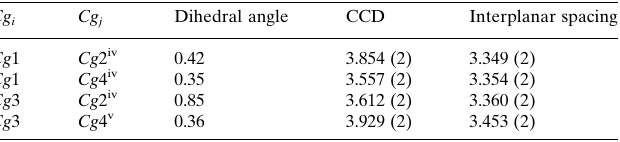
Table 2 (cid:2) – (cid:2) Stacking interactions ( (cid:3) , A˚